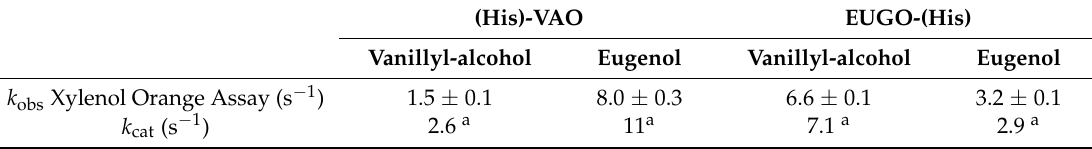
Table 2. Reaction rates for the oxidation of 2 mM vanillyl alcohol or eugenol by His-tagged vanillyl alcohol oxidase (His-VAO) or His-tagged eugenol oxidase (EUGO-His) in 50 mM potassium phosphate buffer, pH 7.5, at room temperature (19–20 °C) as determined using the xylenol orange assay. The k cat values for the non-His-tagged enzymes measured previously using other methods are shown for comparison. These k cat values were measured under identical experimental conditions, with the exception of the temperature, which was 25 °C instead of 19–20 °C.